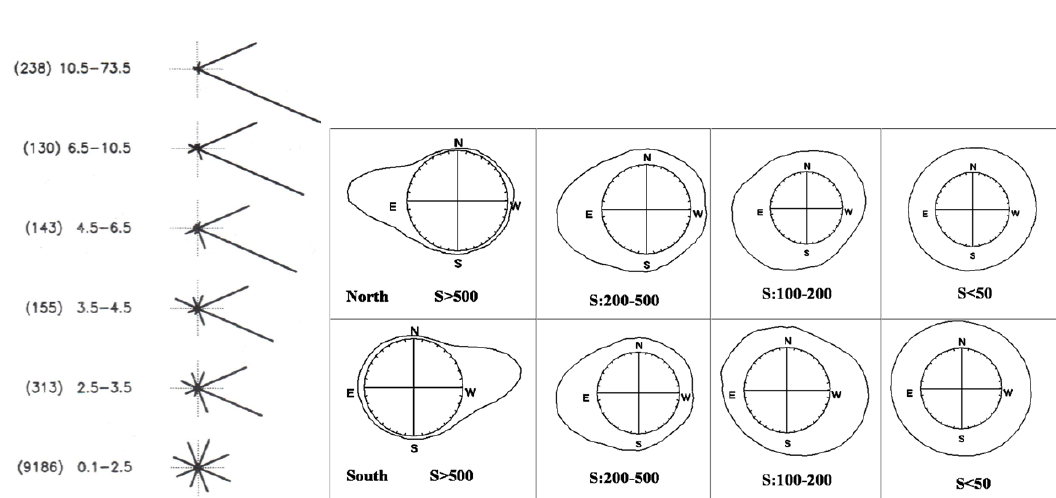
Figure 10: Left: The dependence of the orientation of bipoles on their size shown in an octagonal histogram: Relative numbers in the orientation bins for six area ranges preceded by the number of regions between parentheses based on Harvey’s thesis (1993). Image reproduced with permission from Schrijver and Zwaan (2000), copyright by CUP. Right: Circular histograms of normalised number of bipoles as a function of their tilt separated for the two hemispheres (N: upper row; S: lower row) in four different area bins in MSH as indicated in each panel. The histograms were constructed by Tlatov et al. (2010) for bipoles in the – 30 (cid:176) latitude range identified in SOHO/MDI data during 1998 – 2006. Image reproduced with permission, copyright by